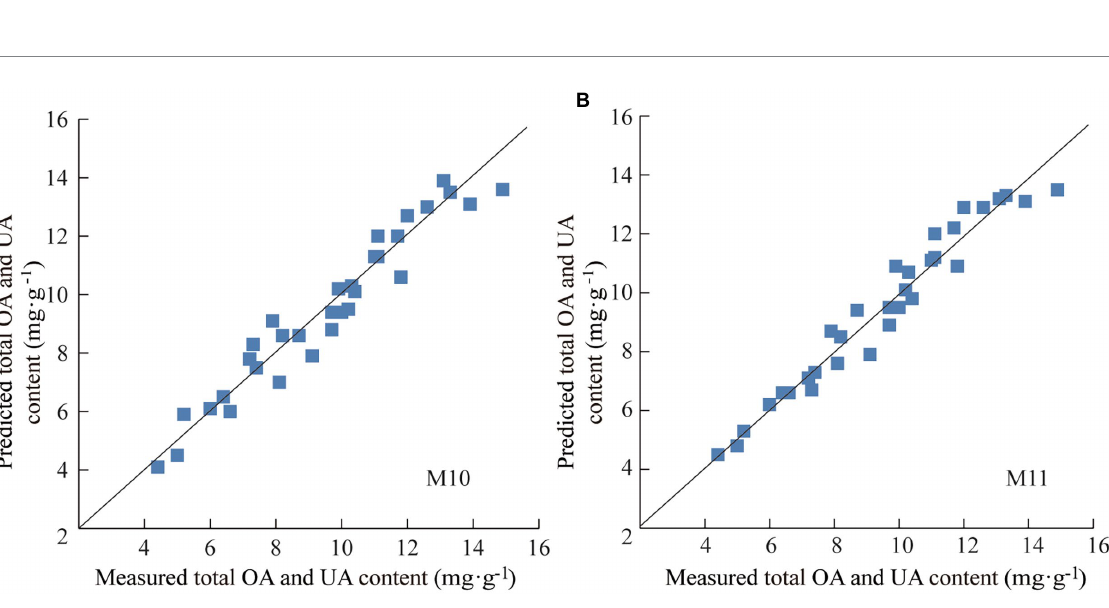
FIGURE 5 Prediction results for the total content of OA and UA of test set samples by model M10 (A) and M11 (B)